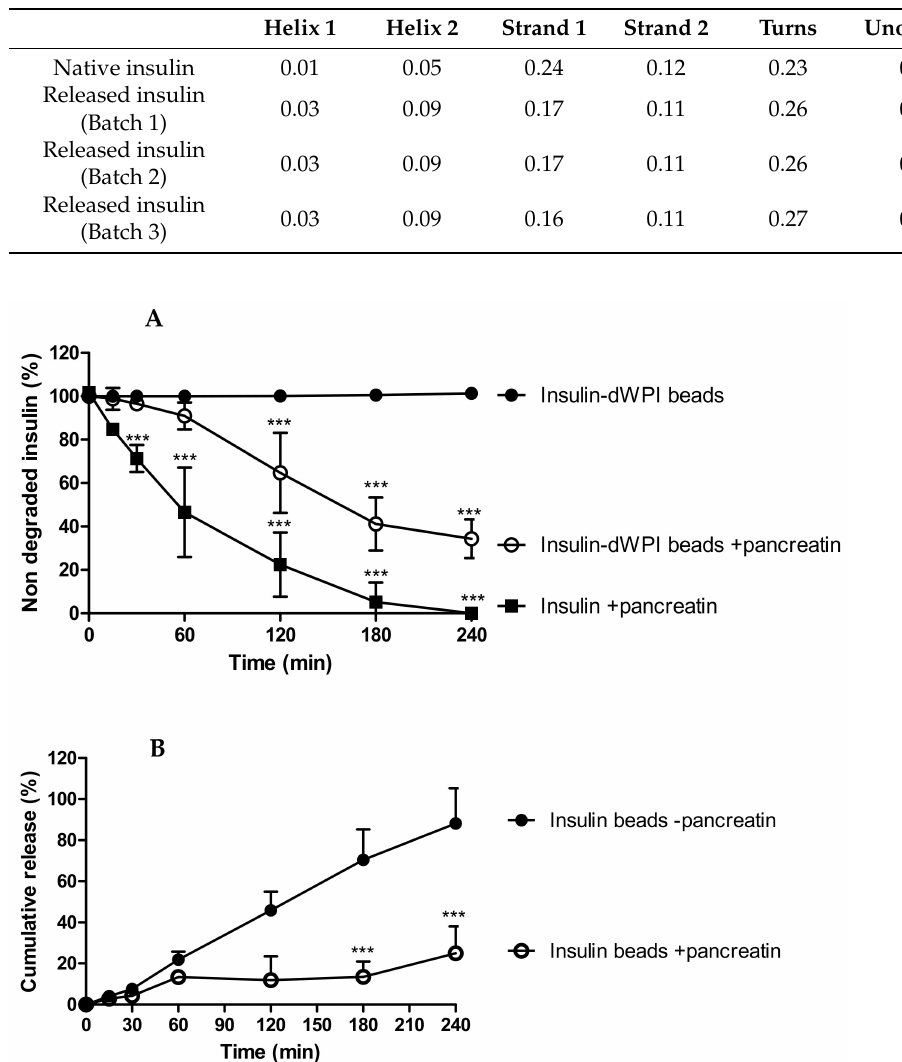
Figure 4. The degradation of insulin released from dWPI beads over 4 h in SIF and SIF supplemented with pancreatin. Data are presented as ( A ) the percentage of insulin remaining following exposure to pancreatin, and ( B ) the effect of pancreatin on the cumulative release of insulin from the dWPI beads. In both cases, insulin released in the absence of pancreatin was used as a control. Native insulin (1 mg/mL) was used to confirm enzyme activity. (Mean ± SD, *** p < 0.001 compared to insulin beads in the absence of pancreatin, ( n =